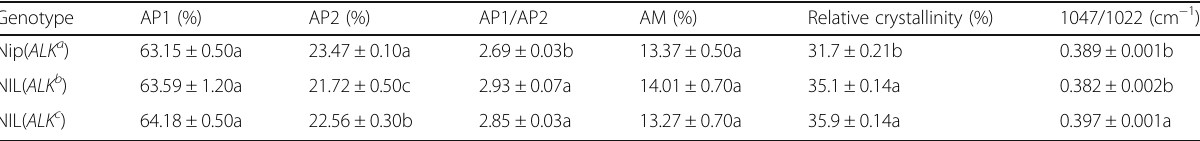
Table 1 Gel permeation chromatography (GPC) parameters, relative crystallinities and infrared ratios (IR) among near-isogenic lines (NILs) a